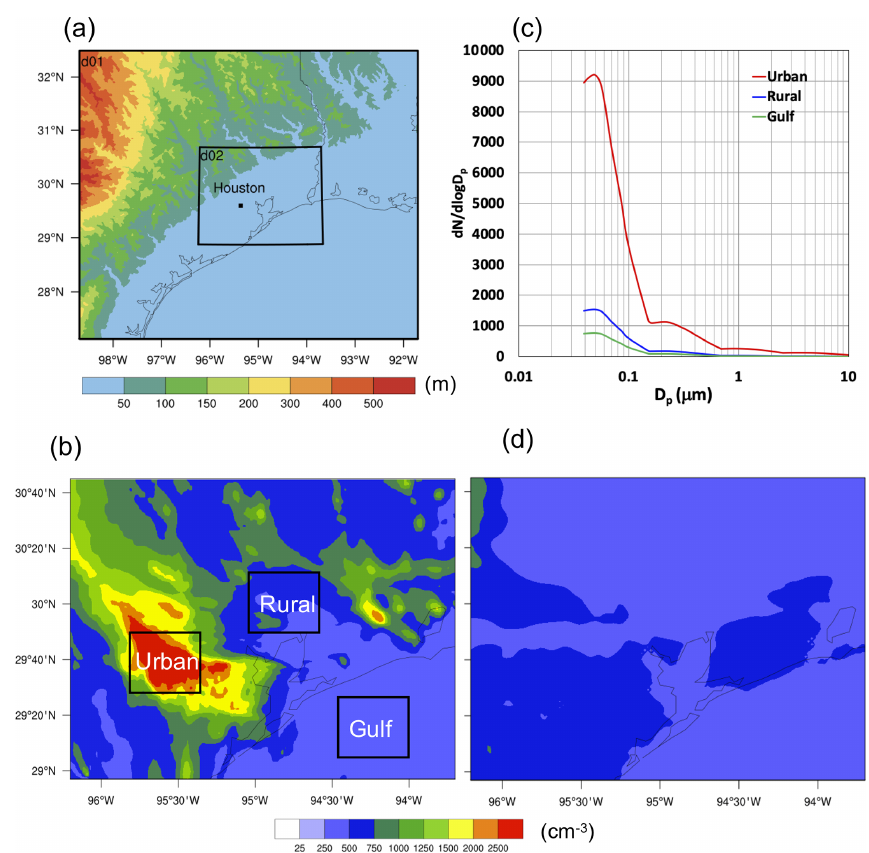
Figure 2. (a) Simulation domains with the terrain heights (unit: m). (b) Aerosol number concentration (unit:cm − 3 ) from D1_MOR_anth. (c) Aerosol size distributions over the urban areas, rural areas, and the Gulf of Mexico as marked by the three black boxes in Fig. 2b at 12:00UTC on 19 June 2013 (6h before the convection initiation). (d) The same as Fig. 2b but for D1_MOR_noanth in which the anthro- pogenic aerosols are